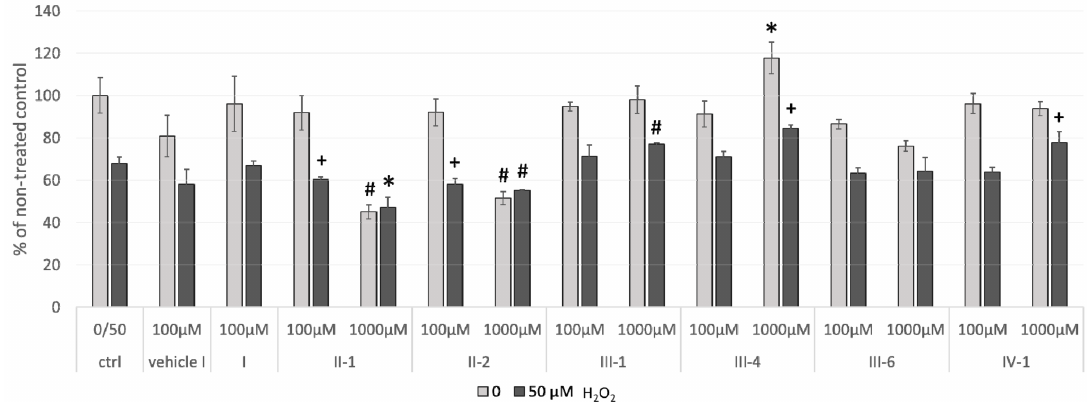
Figure 2. Cellular viability measured by EZ4U assay upon 1 h treatment with DHPs and H 2 O 2 . HOS cells were first treated with DHPs (100 µ M and 1000 µ M) for one-hour, followed by one-hour treatment with 50 µ M hydrogen peroxide or with plain medium. Values are given as mean ± standard deviation; n = 3. Statistically significant differences to their respective controls are shown as follows: * p < 0.05; + p < 0.005; # p <